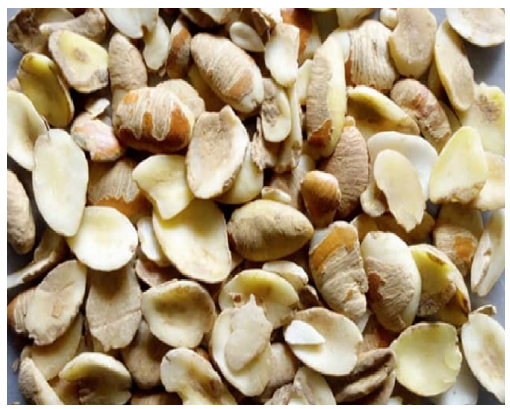
Fig. 2 Sample of Irvingia gabonensis